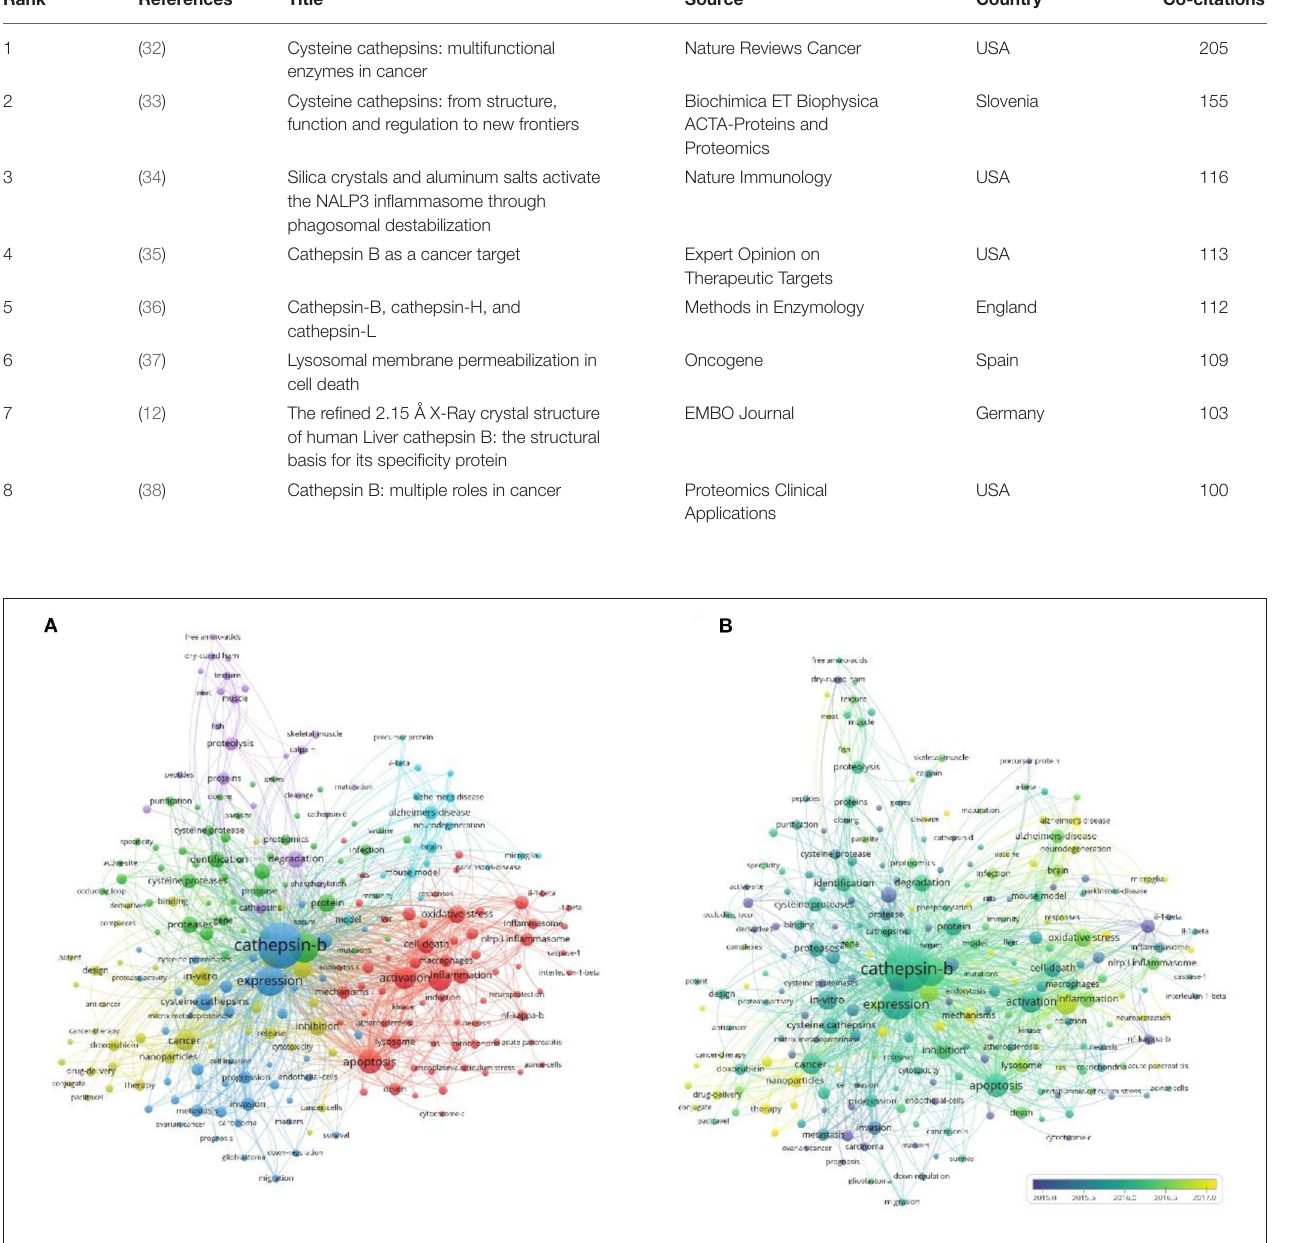
FIGURE 5 | Co-occurrence analysis of keywords. (A) Network visualization map of keywords; (B) Overlay visualization map of keywords.